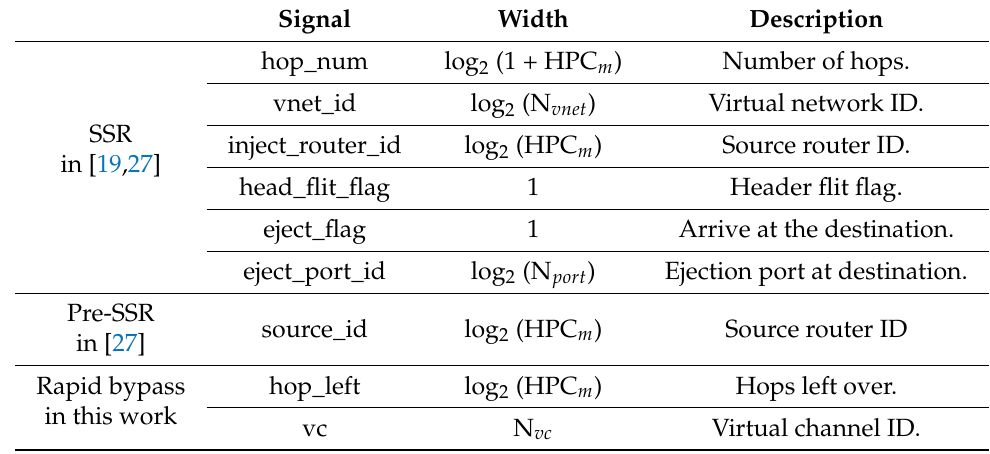
Table 2. SSR signal